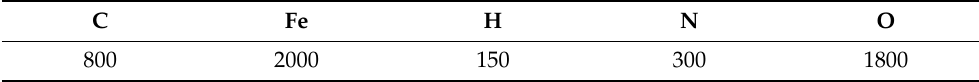
Table 2. Nominal composition of titanium sample with mass purity of 99.5% (mass ppm). C Fe H N O 800 2000 150 300